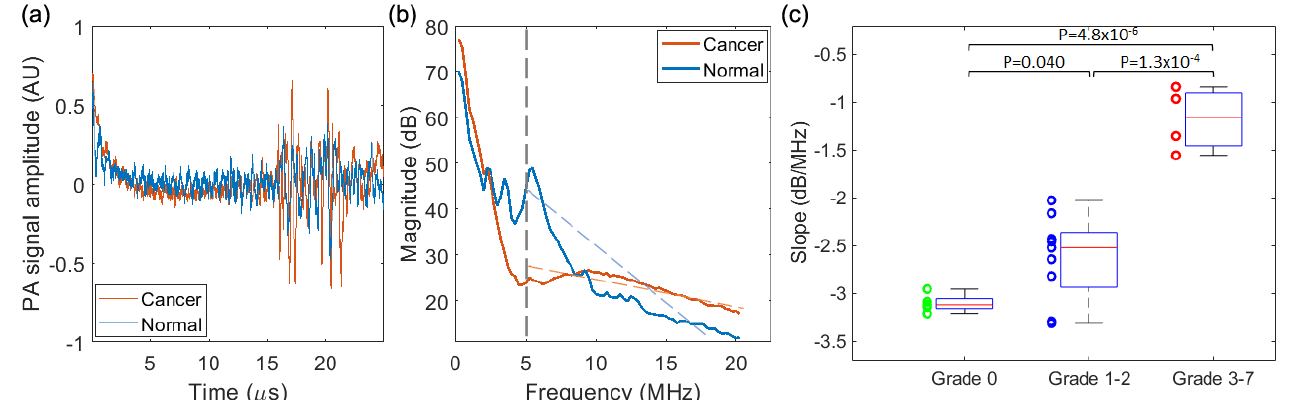
Figure 6. PASA results from the prostates of 18 TRAMP mice acquired by the needle hydrophone. ( a ) PA signals from a cancerous prostate and a normal prostate. ( b ) Power spectra of the PA signals from the cancerous prostate and the normal prostate. The linear fi t of the power spectrum in the range of 5–20 MHz leads to the spectral parameter slope . ( c ) Quanti fi ed spectral parameter slopes of the prostates categorized in three groups, including Grade 0, Grades 1–2, and Grades 3–7, based on pathological evaluation. Two-tailed t -tests between the groups were performed, and those with sta- tistically signi fi cant di ff erences are marked in ( c ).